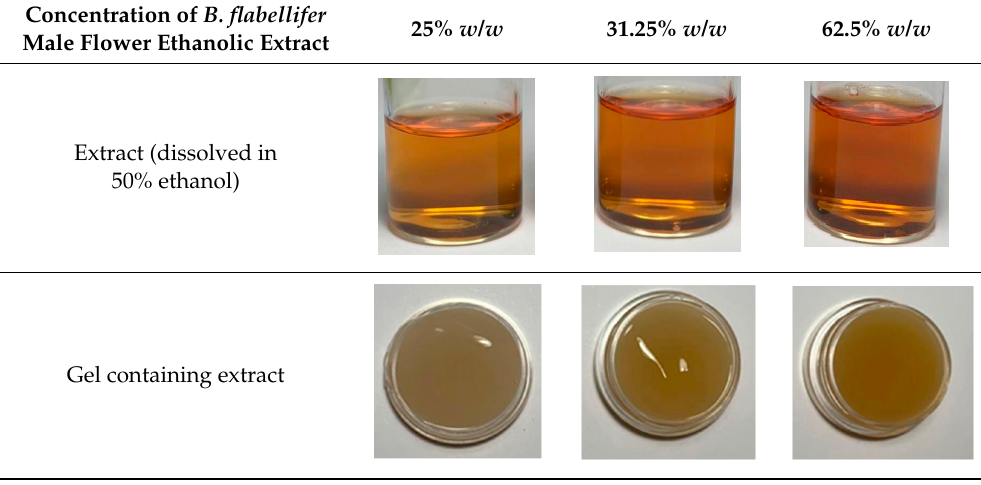
Figure 9. ( A ) Effects of six heating–cooling cycles on the viscosity of gel containing 25, 31.25, and 62.5 % w/w of B. flabellifer male flower ethanolic extract. ( B ) Effect of temperature on the viscosity of gel containing 25, 31.25, and 62.5 % w/w of B. flabellifer male flower ethanolic extract after storage at 4, 30, and 45 °C for 1 month. * Indicated p < 0.05, and ** indicated p < 0.01.